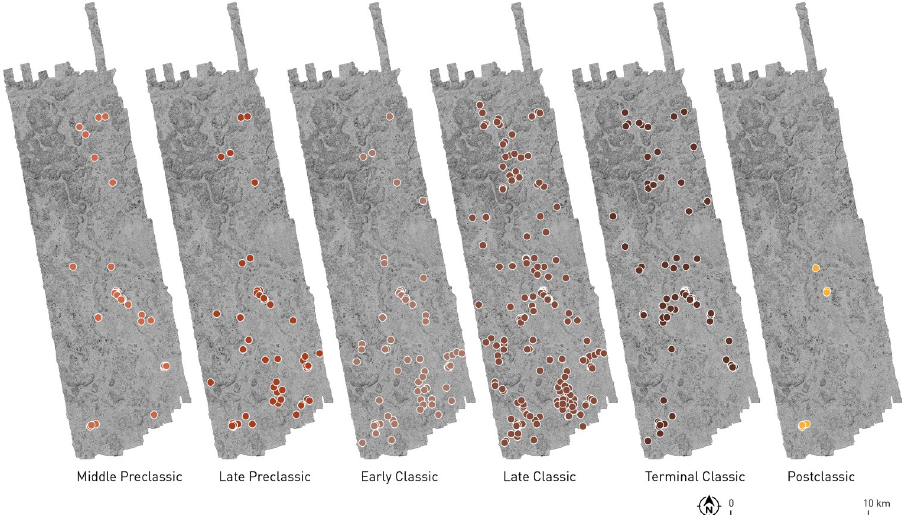
Fig 16. Distributions of ceramics from different